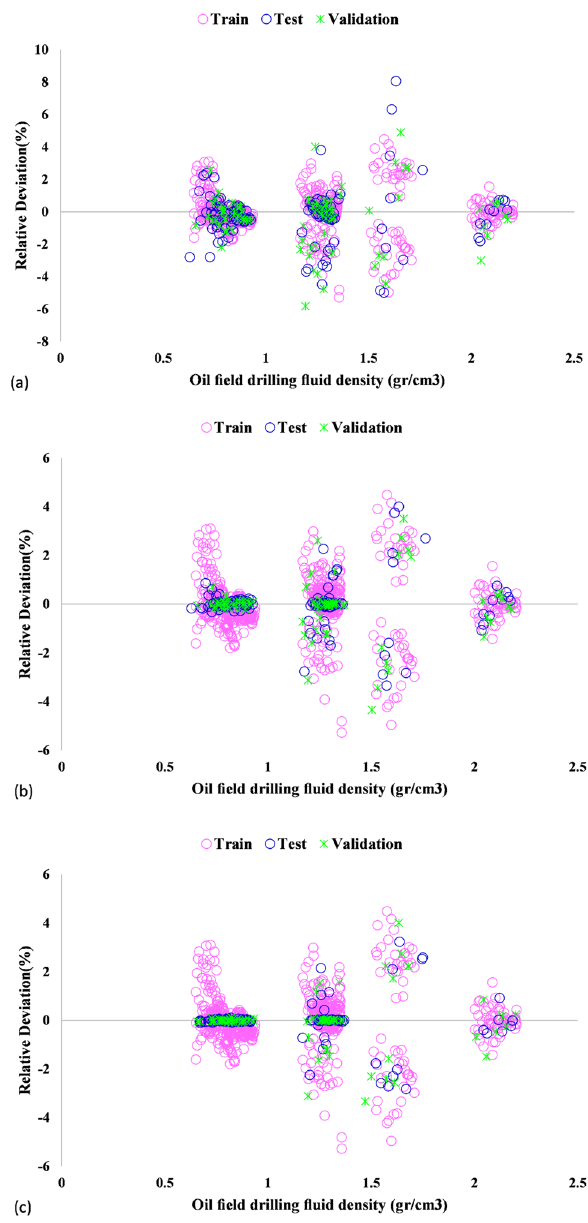
Figure 6. Relative deviations of the training, validation and testing datasets by ( a ) GA-LSSVM, ( b ) ICA- LSSVM, and ( c )